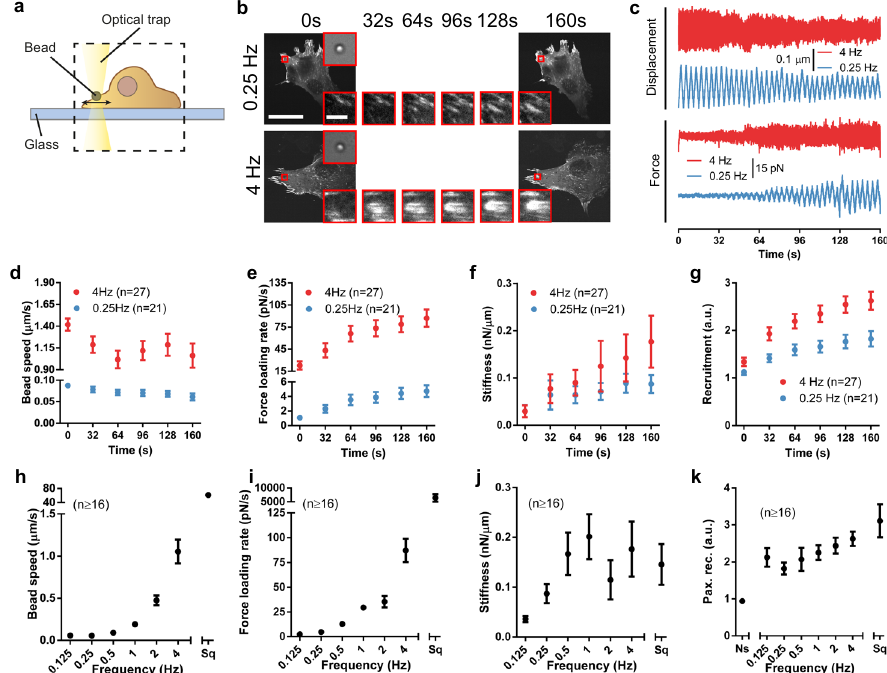
Fig. 3 The loading rate of force application to single adhesions drives their maturation. a Illustration of the optical tweezer setup. b Images of cells transfected with GFP-paxillin during force application with triangular signals at 0.25 and 4 Hz, shown as a function of time. The area circled in red indicates the position of the stimulated bead, which is shown magni fi ed at the top-right corner (bright fi eld image) and bottom-right corner (GFP-paxillin image). Magni fi ed GFP-paxillin images are shown at different timepoints. c Example traces of displacement and forces for beads stimulated at 4 and 0.25 Hz. d – g Bead speed ( d ), force loading rate ( e ), stiffness ( f ), and recruitment of GFP-paxillin at beads ( g ) as a function of time for beads stimulated at 4 Hz and 0.25 Hz. h – k Bead speed ( h ), force loading rate ( i ), stiffness ( j ), and recruitment of GFP-paxillin at beads ( k ) for beads at the end of the experiment (160 s) for all conditions. The effects of frequency on both stiffness and paxillin recruitment were signi fi cant ( p = 0.002 and 0.008, respectively). Ns non-stimulated beads, Sq stimulation with a 1 Hz square signal. n numbers are beads in all panels. Statistical signi fi cance was assessed with Kruskal – Wallis test. Scale bar is 50 µ m, and 5 µ m in magni fi cations. Data are shown as mean ±